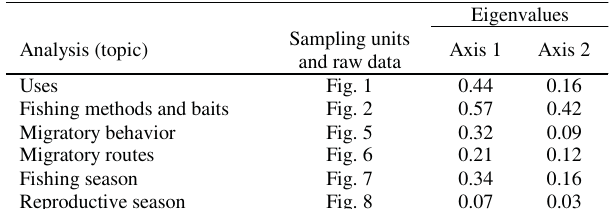
Table 2. Results of multivariate correspondence analyses based on percentage of interviewed fishermen who cited each of the information related to topics analyzed: numbers of eigenvalues are related to the amount of variance in the data set explained by each ordination axis (from 0 to 1). The corresponding ordination plots are shown in the figures and the raw data (percentages) are shown in